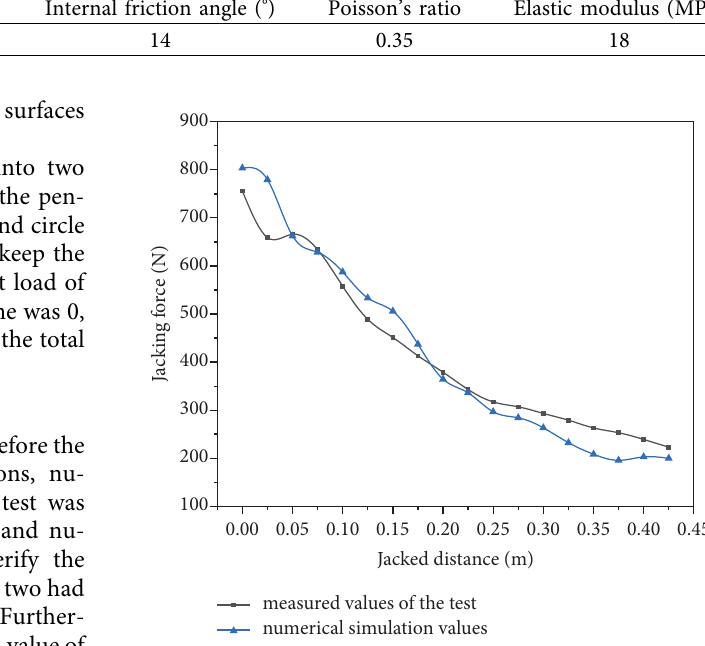
Figure 7: Comparison of jacking